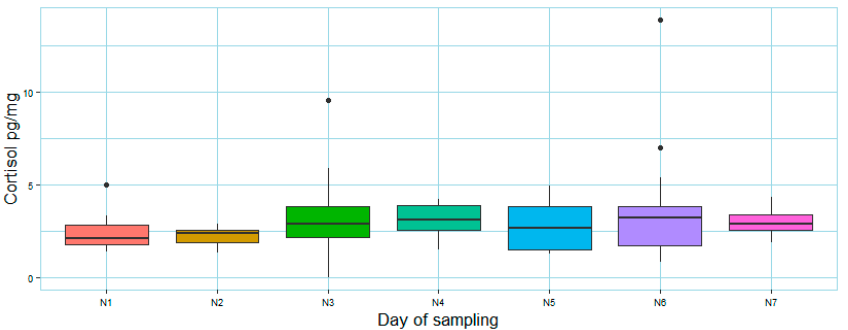
Figure 3. Fecal cortisol (pg/mg) measured from samples collected every day of the JBT week (N1 = habituation, N2 = training, N3 = resting day, N4 = test1, N5 = test2, N6 = resting day after the last test day, N7= second resting day after the last test day). The bar within the box represents the median, the borders of the box are upper and lower quartiles, the bottom and top whiskers signify the lowest and highest cases within 1.5 times the IQR, and outliers are shown through black full circles. In addition, we did not find significant influence of the chronic activation of HPA